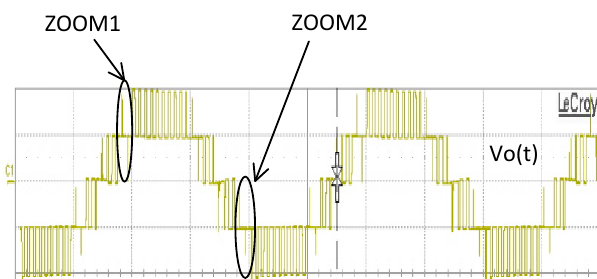
Electronics 2019 ,12, x; doi: FOR PEER REVIEW Figure 20. Output voltage of the converter with LS-PWM control. Figure 20. Output voltage of the converter with LS-PWM control.